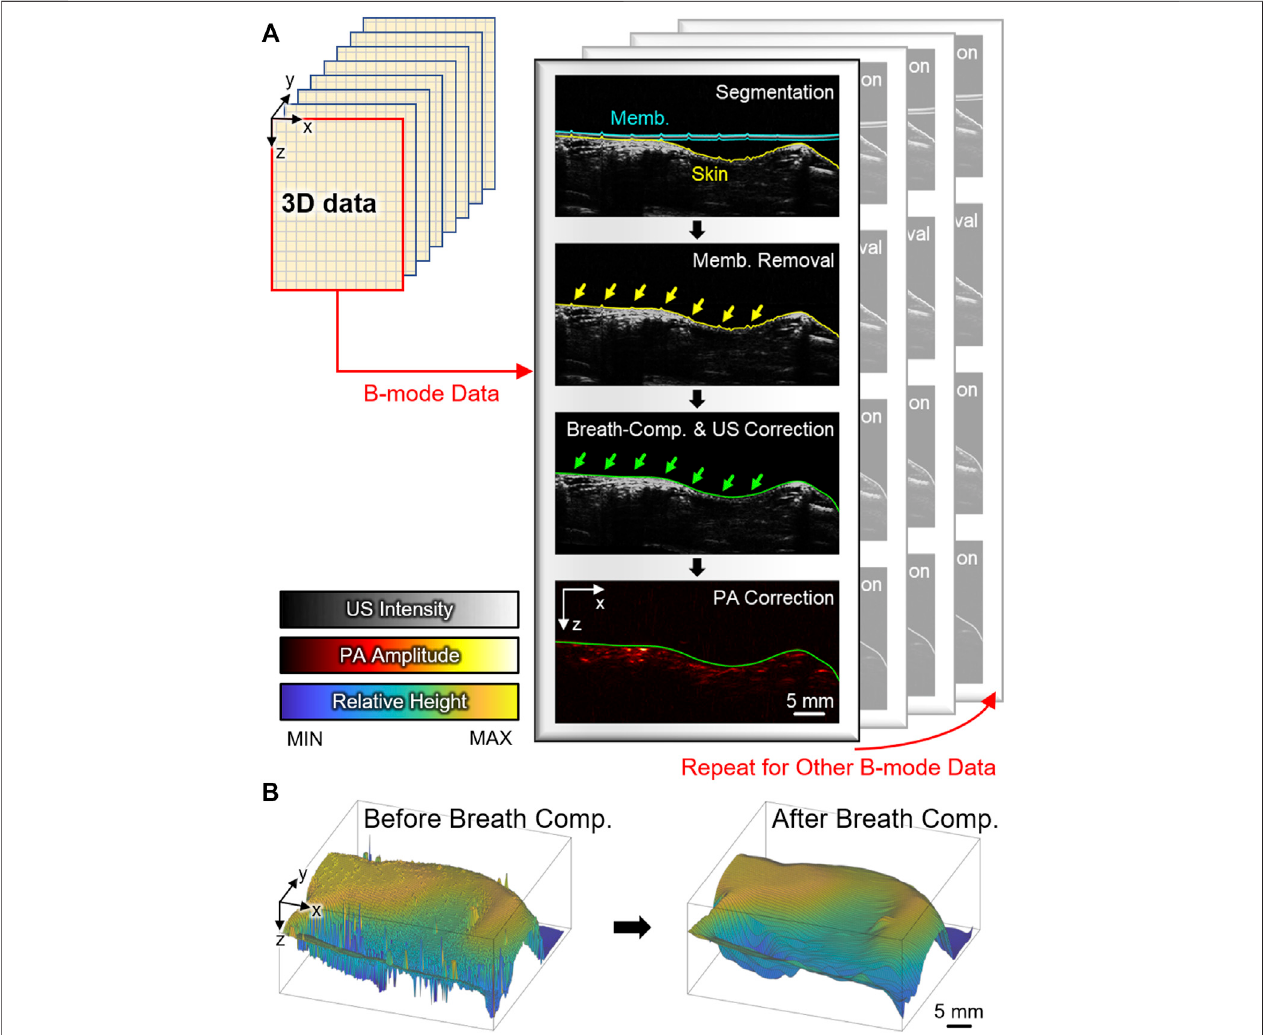
FIGURE 2 | (A) Schematic illustration of the US-guided breath-compensation procedure. Blue, yellow, and green lines denote membrane, original skin, and corrected skinlayers,respectively. Yellow and green arrows arerespiratorydistortionsbeforeand after correction. (B) Surfacepro fi leoftheskinbeforeand after breath- compensation. PA, photoacoustic; US, ultrasound; Memb., membrane; Comp., compensation.